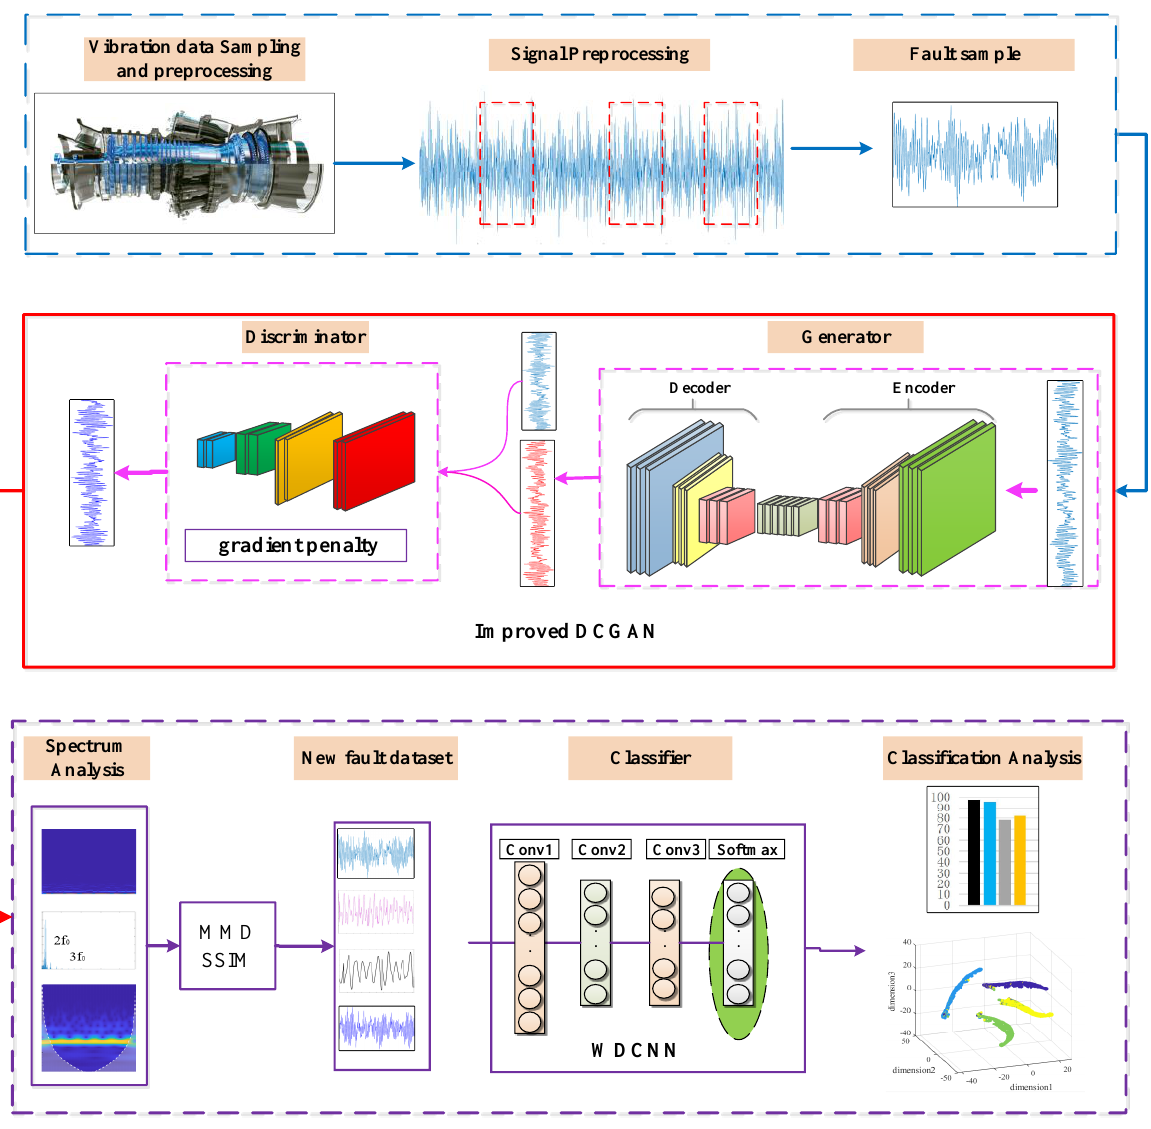
Figure 4. Flow chart of the proposed gas turbine rotor fault diagnosis method.